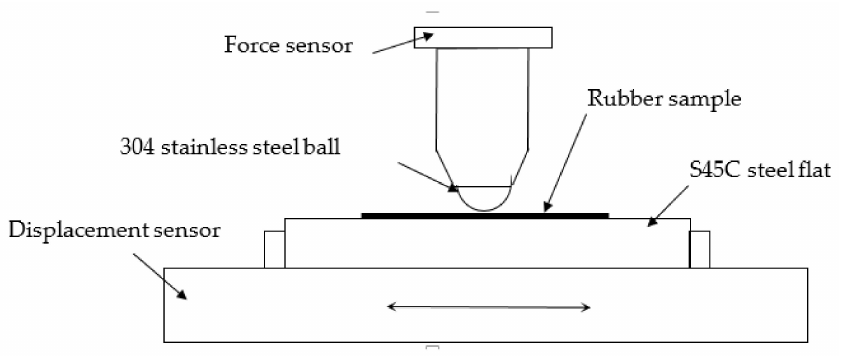
Figure 1. Schematic map of the fretting wear setup.